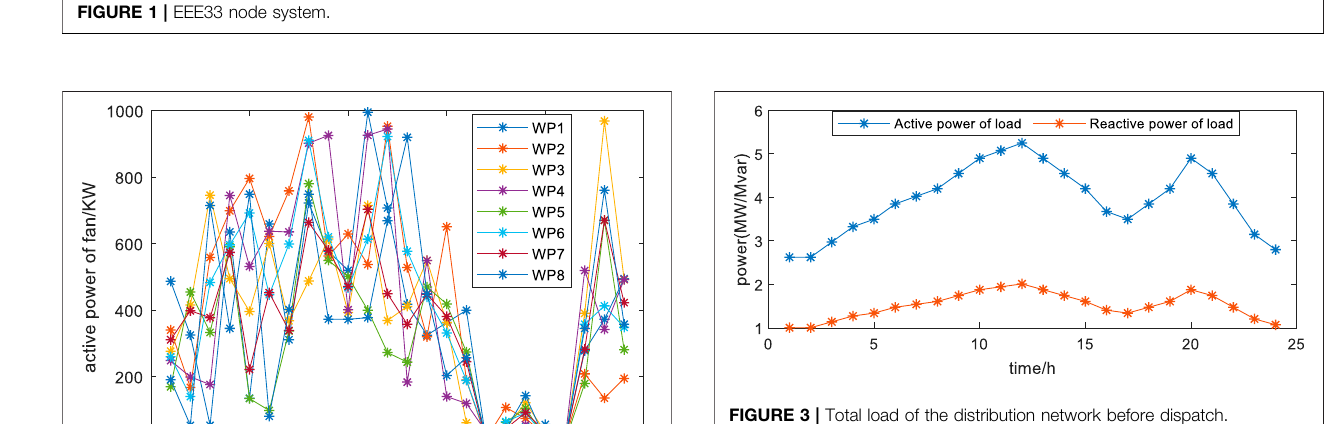
FIGURE 1 | EEE33 node system.